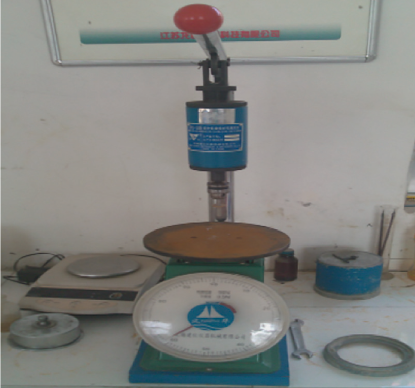
Figure 3: Setting time tester.